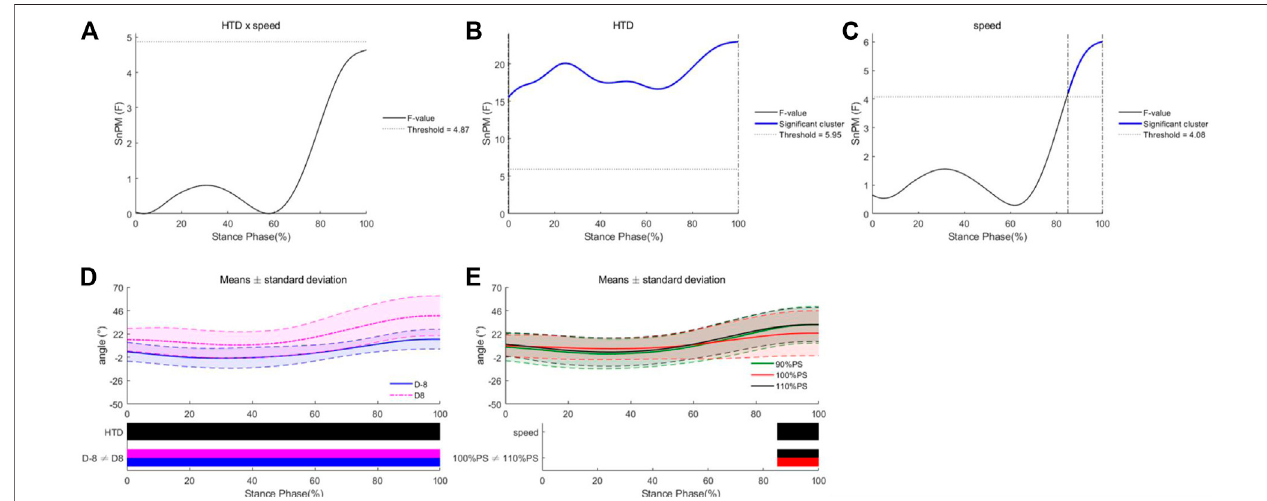
FIGURE 3 | Differences of MTP angles in the sagittal plane under different HTDs and running speeds. Interaction (A) , main effects of HTD (B) and speed (C) , post hoc test for HTD (D) , and post hoc test for speeds (E) .